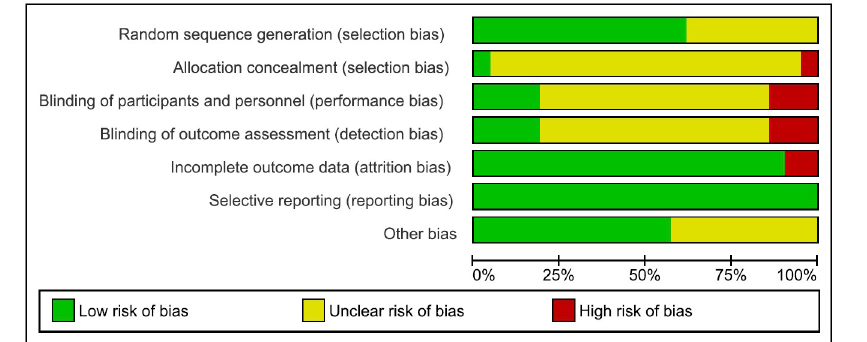
Fig 2. Risk of bias graph: Risk of bias presented as percentages across all included